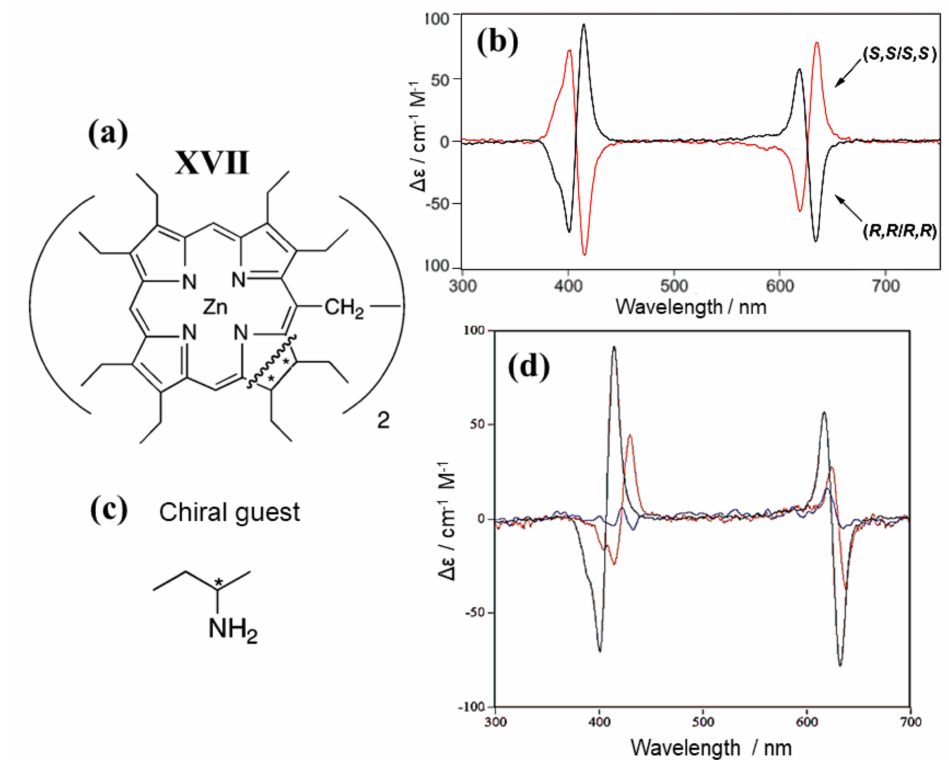
Figure 14. ( a ) Structure of the chiral Zn(II)-bis-porphyrinoid XVII ; ( b ) CD spectra of enantiomers of chiral Zn(II)- XVII in dichloromethane; ( c ) Structure of the chiral 2-aminobutane; ( d ) CD spectra of (R, R/R, R)-Zinc(II)- XVII before (black line) and after the addition of (R)-2-aminobutane (red line) and (S)-2-aminobutane (blue line) in dichloromethane. Figure 14a,c,d adapted with permission from reference [73]; published by American Chemical Society 2005. Figure 14b adapted with permission from reference [74]; published by American Chemical Society